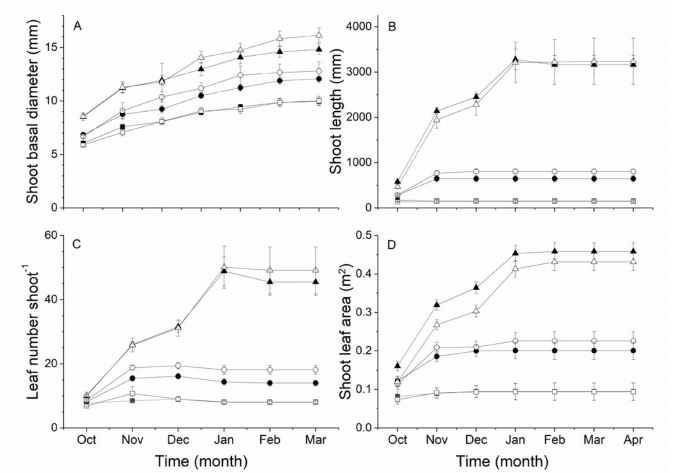
Figure 3. The effect of shoot type and rootstock on ( A ) shoot basal diameter, ( B ) shoot length, ( C ) leaf number per shoot and ( D ) total shoot leaf area of Actinidia chinensis var. chinensis ‘Zes008 (cid:48) shoots over a growing season. Shoots were growing on vines on either A. chinensis var. deliciosa ‘Bruno’ rootstock (short (cid:4) , medium • or long (cid:78) shoots) or an A. macrosperma rootstock (short (cid:3) , medium shoots). Data are means ± SEM, n =